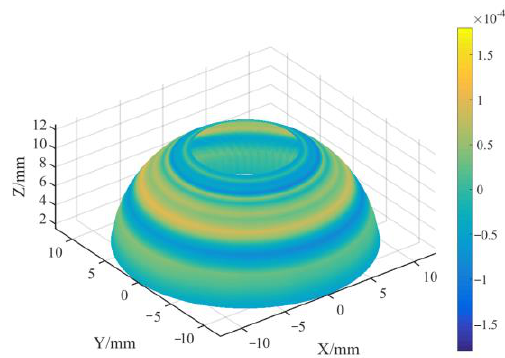
Figure 11. Local profile measurement results of a standard sphere.